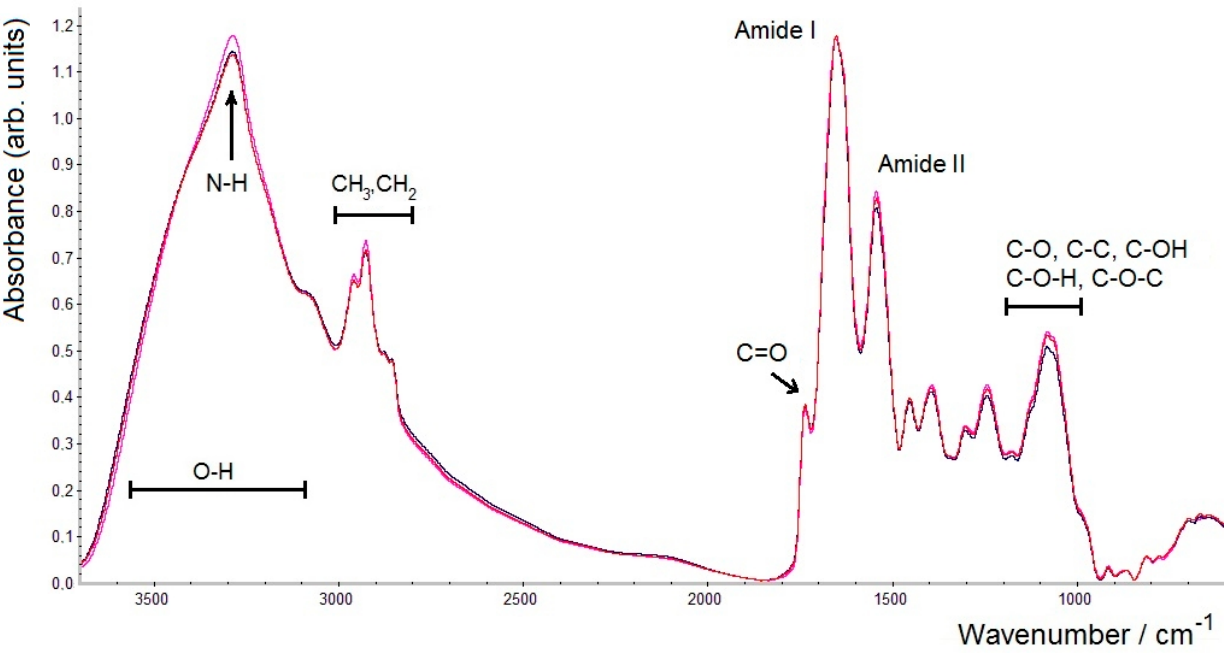
Figure 4. FTIR spectra of three samples of A. brasilense Sp7 biomass dried for 23 h (3 replicates) normalised by the amide I band.